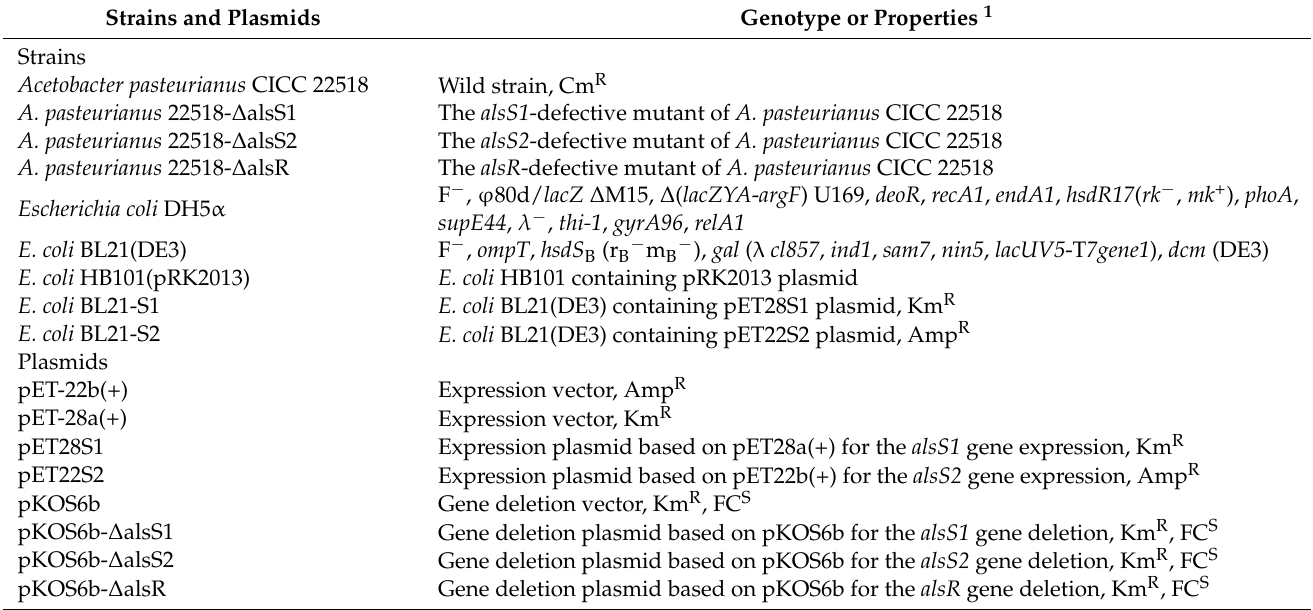
Table 1. The bacterial strains and plasmids used in this study.